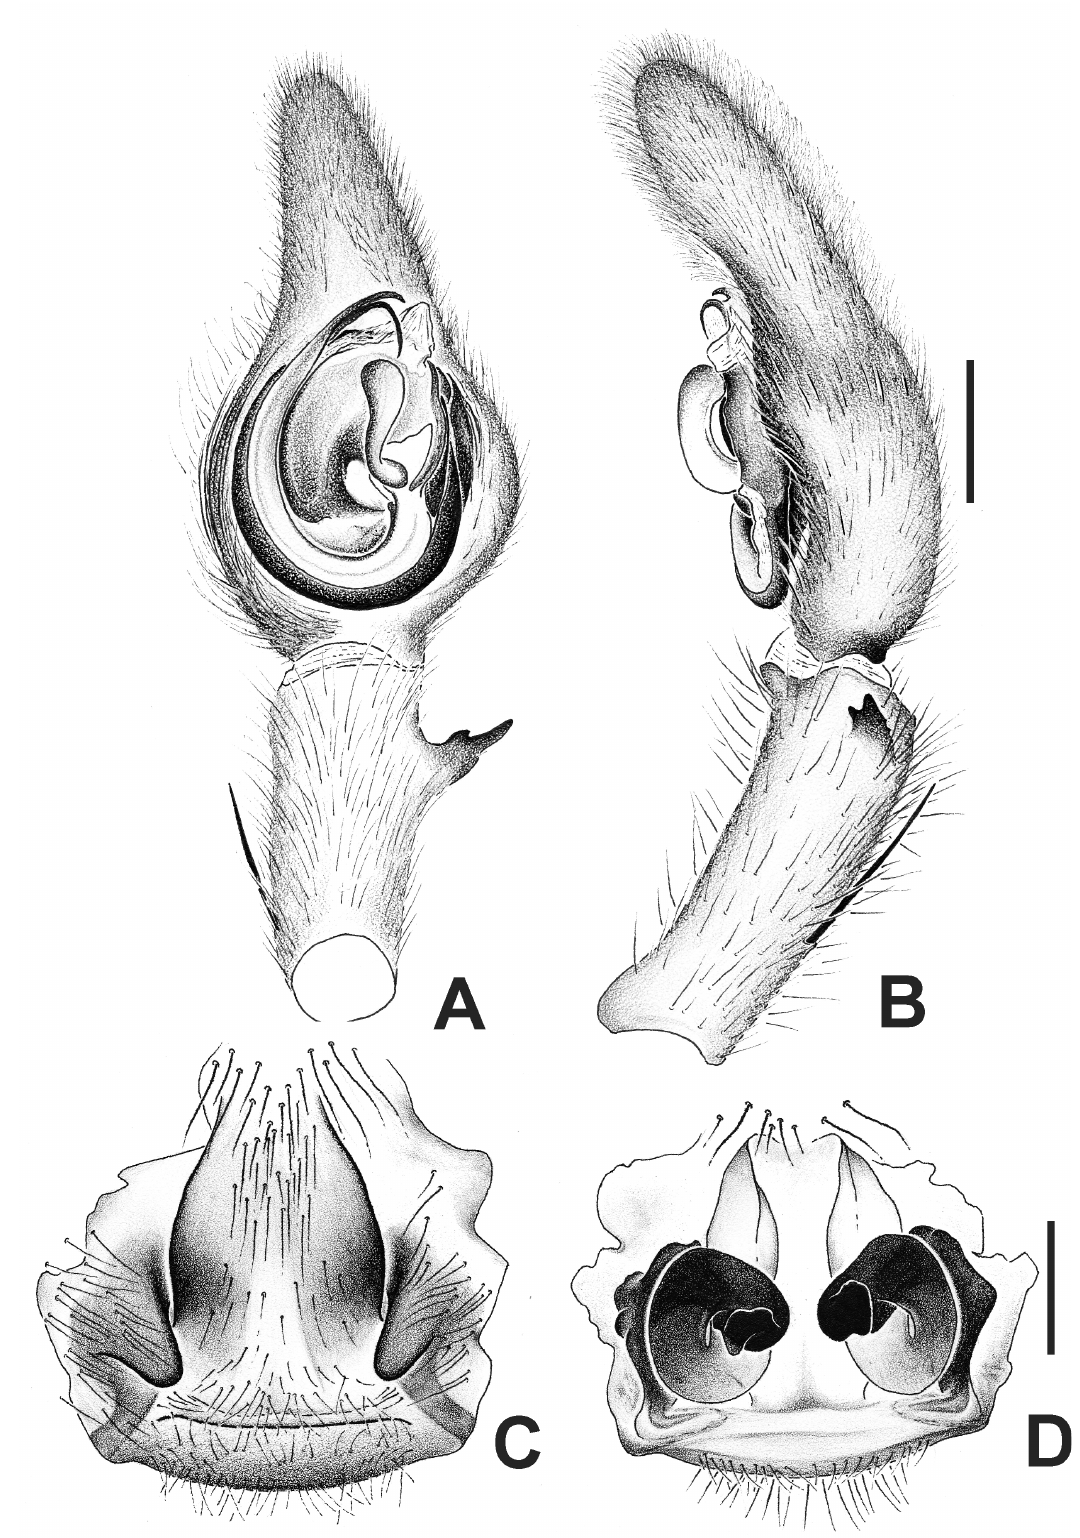
Fig. 7. Afroneutria erythrochelis (Simon, 1876) comb. nov. — A–B . Male palp. A . Ventral view. B . Retrolateral view. — C–D . Female genitalia. C . Epigynum, ventral view. D . Vulva, dorsal view. Scale bars = 1